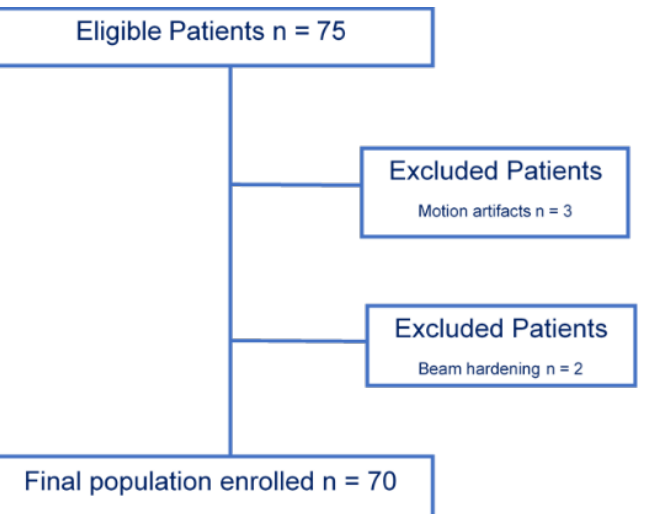
Figure 1. Population enrollment flow-chart. A total of 70 patient were included from an initial population of 75 patients enrolled; three were excluded in relation to motion artefacts, and two were excluded due to beam hardening artifacts.